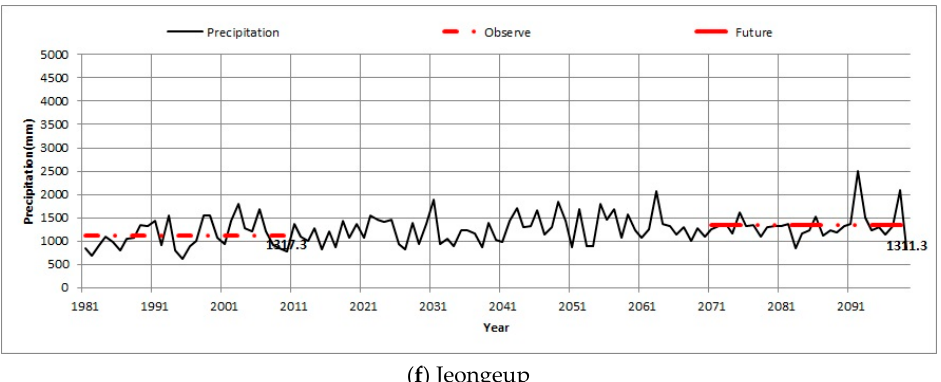
Figure 17. Trend analysis of observed and future annual precipitation. ( a ), ( b ), ( c ), ( d ), ( e ), and ( f ) each represent graphs of Uljin, Seogwipo, Busan, Inje, Yangpyong, and Jeongeup.